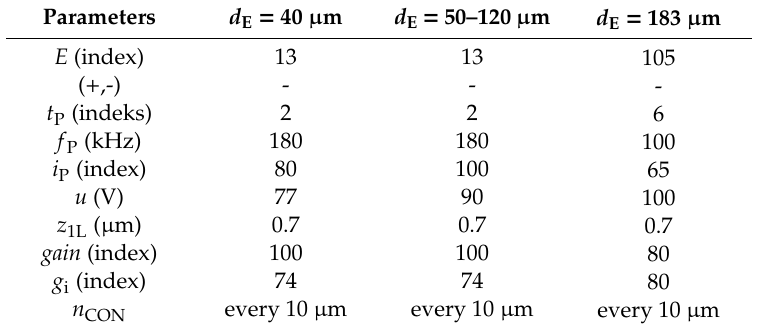
every 10 µ m Denotation of parameters: energy index E , polarity, duration of discharge pulse t p , discharge frequency f p , discharge current i p , ignition voltage u , gain index gain , gap index g i , machining layer depth z 1L , and number of controls of electrode axial wear n CON .